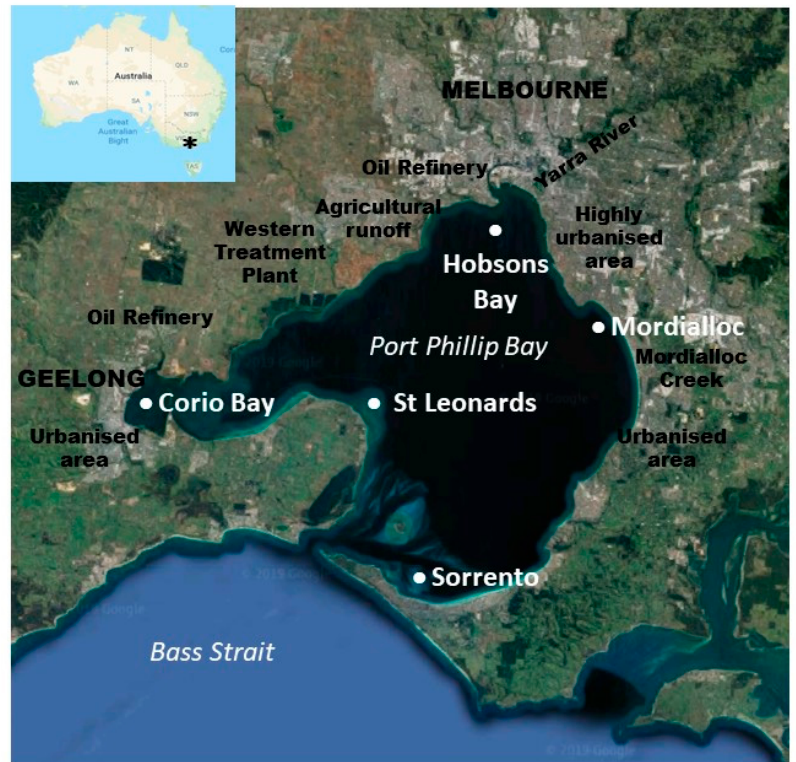
Figure 1. Map showing the location of sampling sites where sand flathead ( Platycephalus bassensis ) were collected in Port Phillip Bay, Victoria, Australia in March 2015. Land use in the surrounding areas and proximity to the cities of Melbourne and Geelong are also included.